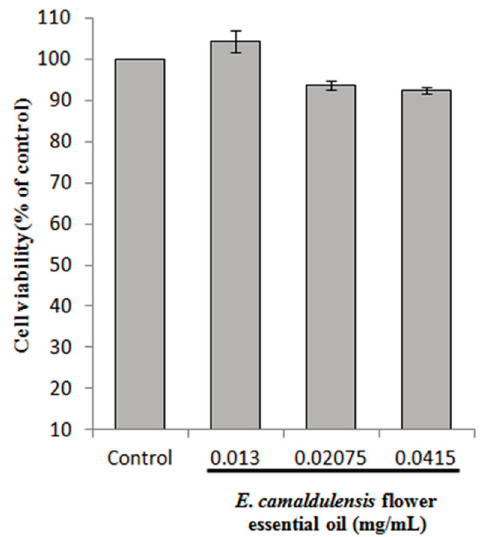
Figure 1. Effect of E. camaldulensis flower essential oil on B16F10 cell viability. Cells